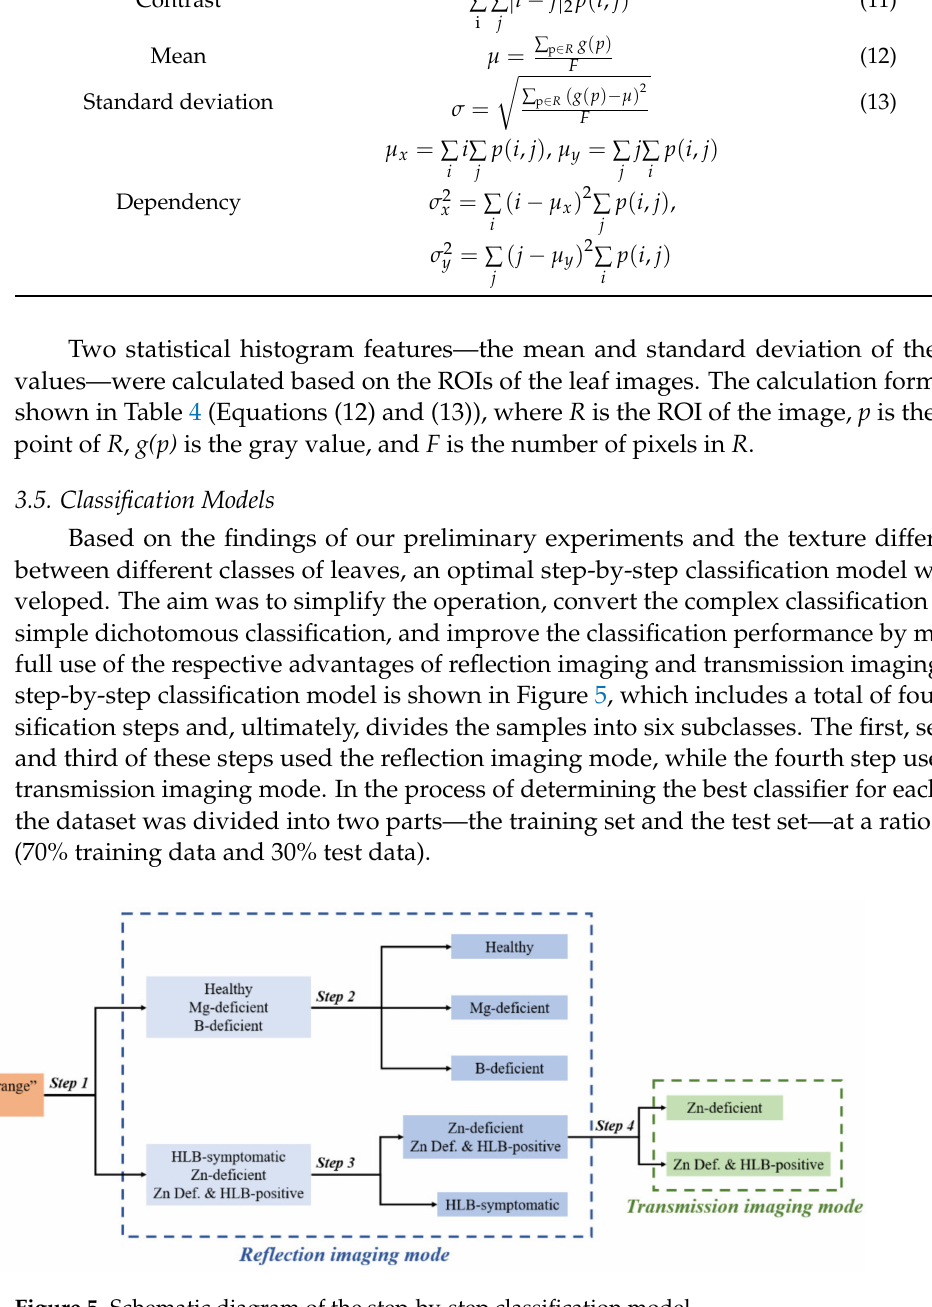
Figure 5. Schematic diagram of the step-by-step classification